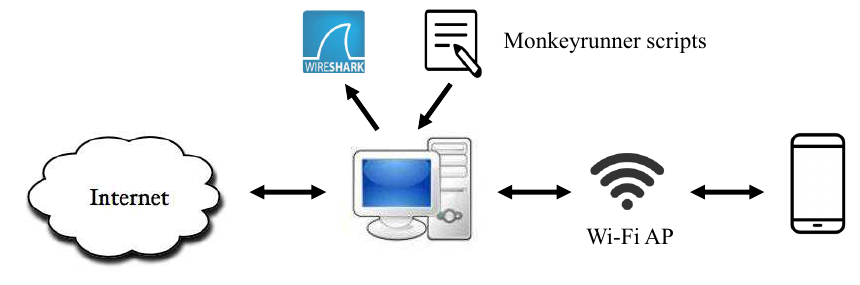
Figure 3. Configuration environment of traffic